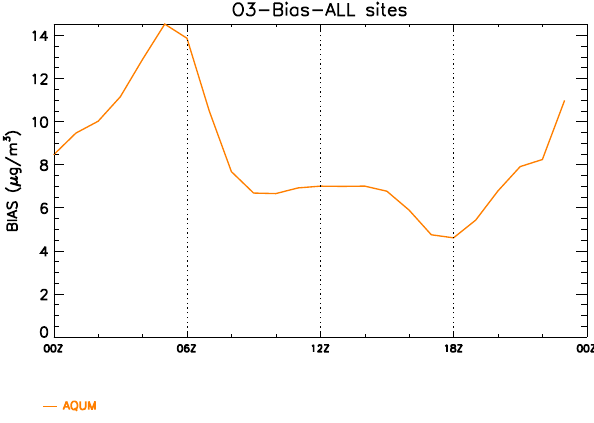
Table 2. Model performance metrics for the period 1 May 2010– 30 April 2011. These statistics are based on all hourly values in each